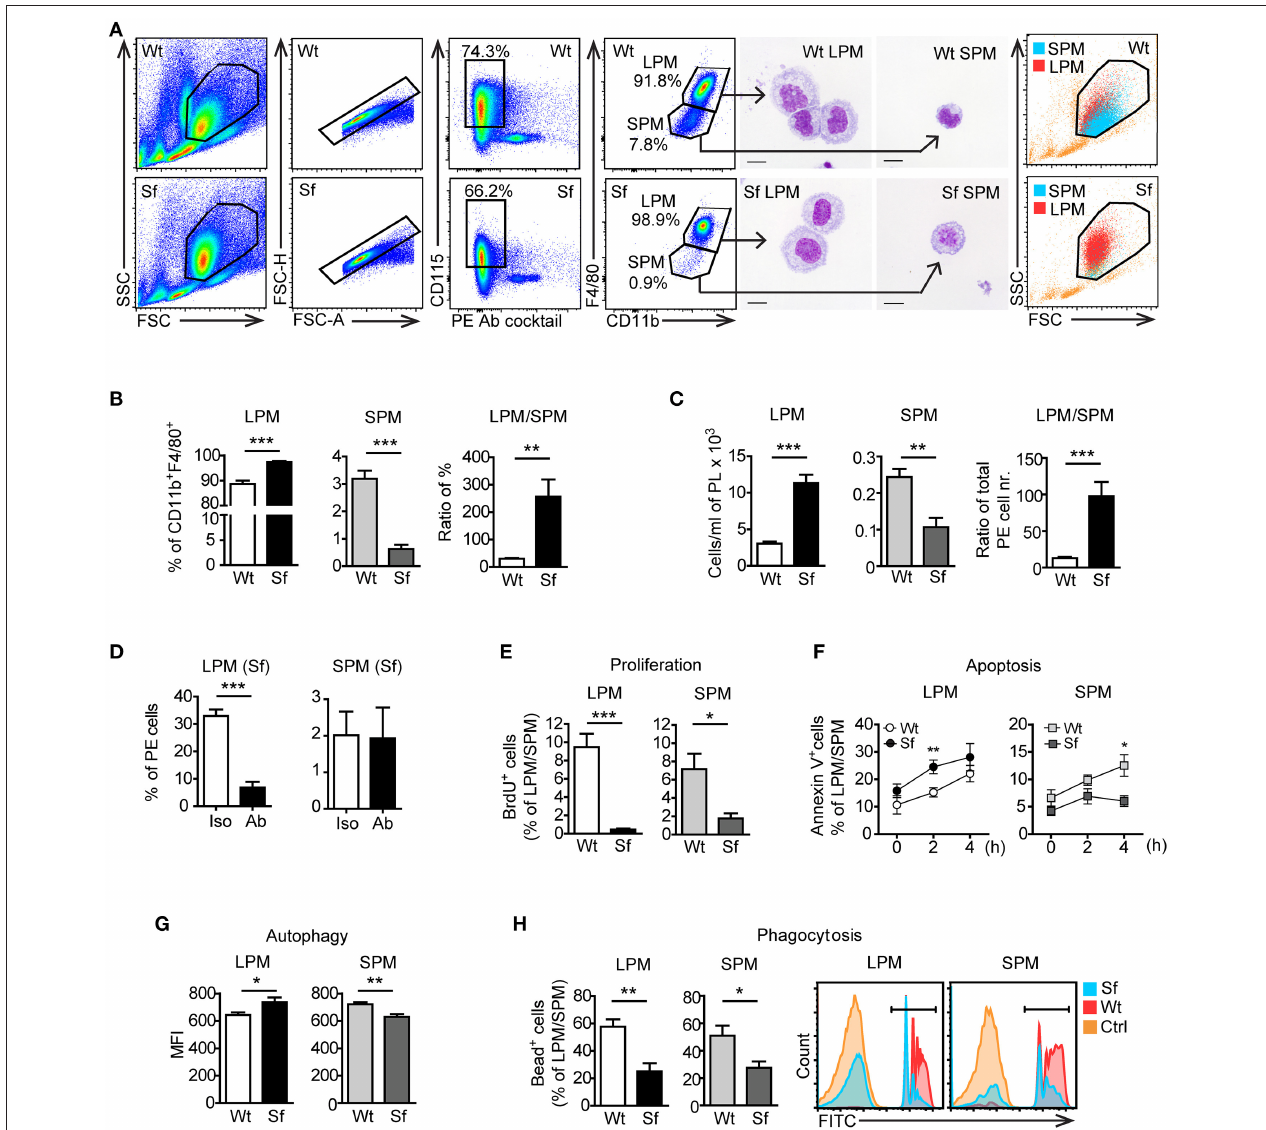
FIGURE 5 | Peritoneal macrophage subsets and their effector functions are skewed due to the absence of regulatory T cells. (A) Gating strategy used to identify large peritoneal macrophages (LPM) and small peritoneal macrophages (SPM) by flow cytometry. Cells were FACS sorted and stained with May-Grünwald/Giemsa. Data shown are representative from > 10 experiments. (B) Percentages ( n = 8) and (C) total cell numbers ( n = 5–6) of CD115 + CD11b high F4/80 high LPM and CD115 + CD11b int F4/80 int SPM in the peritoneal exudate of scurfy (Sf) and littermate control (Wt) mice determined by flow cytometry. (D) Percentages of LPM and SPM in Sf mice within PE after injection of anti-M-CSF antibody (Ab) or isotype (Iso) control antibody ( n = 5 mice, data are pooled from two independent experiments). Flow cytometry analyses of (E) in vivo proliferation ( n = 4, one representative experiment out of three), (F) apoptosis (Annexin V staining; n = 8–11 per time-point), (G) autophagy ( n = 5-6), and (H) phagocytosis rate in vivo ( n = 5) of LPM and SPM in Sf and Wt mice. Statistical analyses were performed using unpaired Student’s t -test, * p < 0.05, ** p < 0.01, *** p < 0.001.